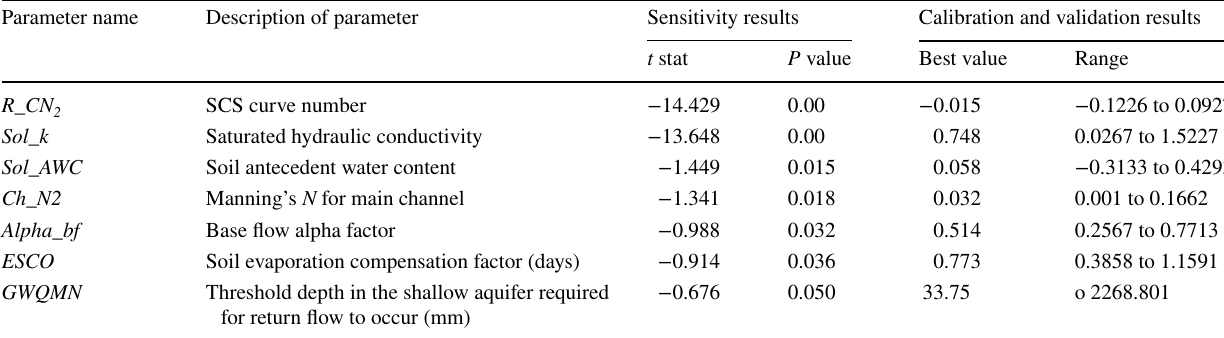
Fig. 6 Land use, soil and SWAT set-up for Tandula catchment Table 6 Results of sensitivity, calibration and validation of SWAT